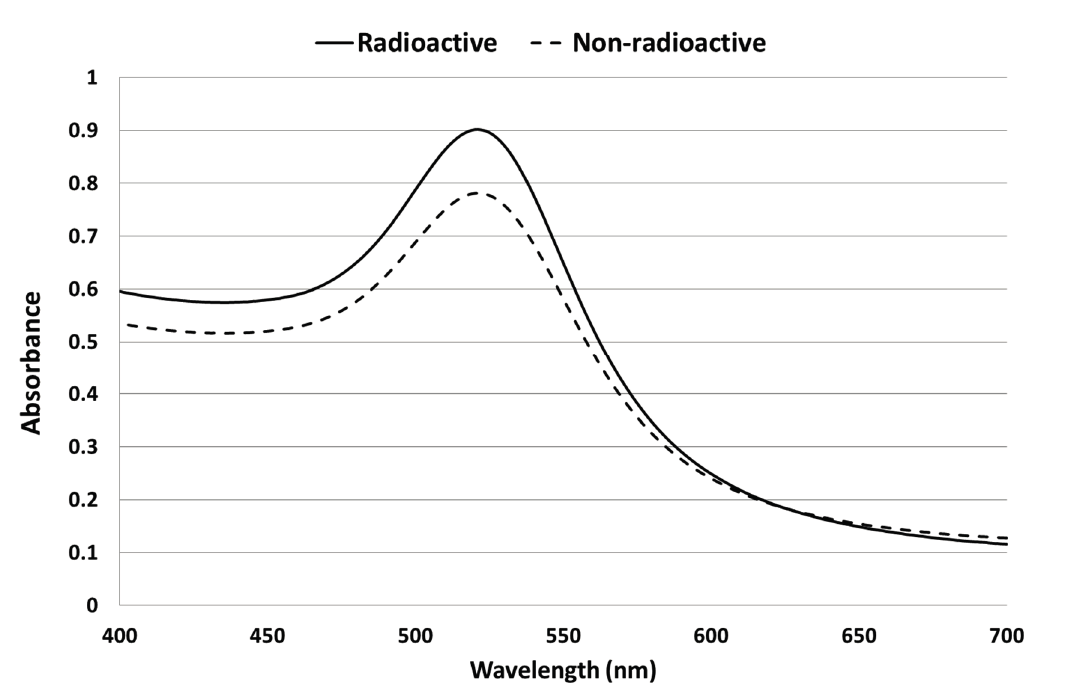
Figure 1. UV-Vis spectra of radioactive ( continuous line ) and non-radioactive ( dashed line ) AuNPs. The measurements were done after the synthesis of both